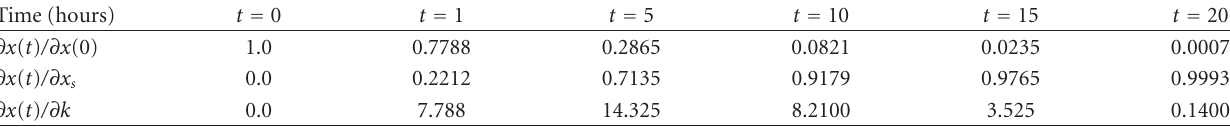
Table 2: Sensitivities of model state to initial conditions and parameters for the sea/air turbulent transfer